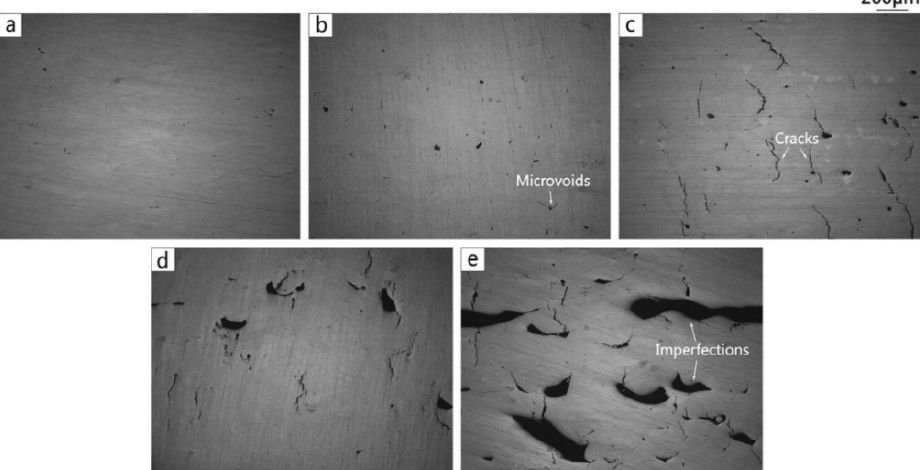
Figure 16. Cross-sections of Al-Cu-Mg samples produced with different scanning speeds: ( a ) 5 m/min, ( b ) 8 m/min, ( c ) 10 m/min, ( d ) 15 m/min, and ( e ) 20 m/min [118]. Copyright 2016. Adapted with permission from Elsevier Science Ltd. under the license number 4803710859427 (Figure 4 [118]), dated